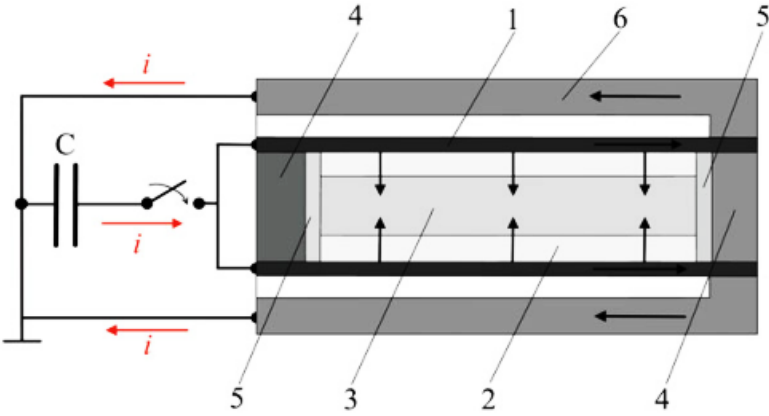
Figure 11. Schematic diagram of magnetic pulse powder compaction: principle scheme of magnetic pulse compaction of tubes: 1 copper shell, 2 powder, 3 steel rod, 4 plug, 5 spacer, 6 reverse conductor [130].